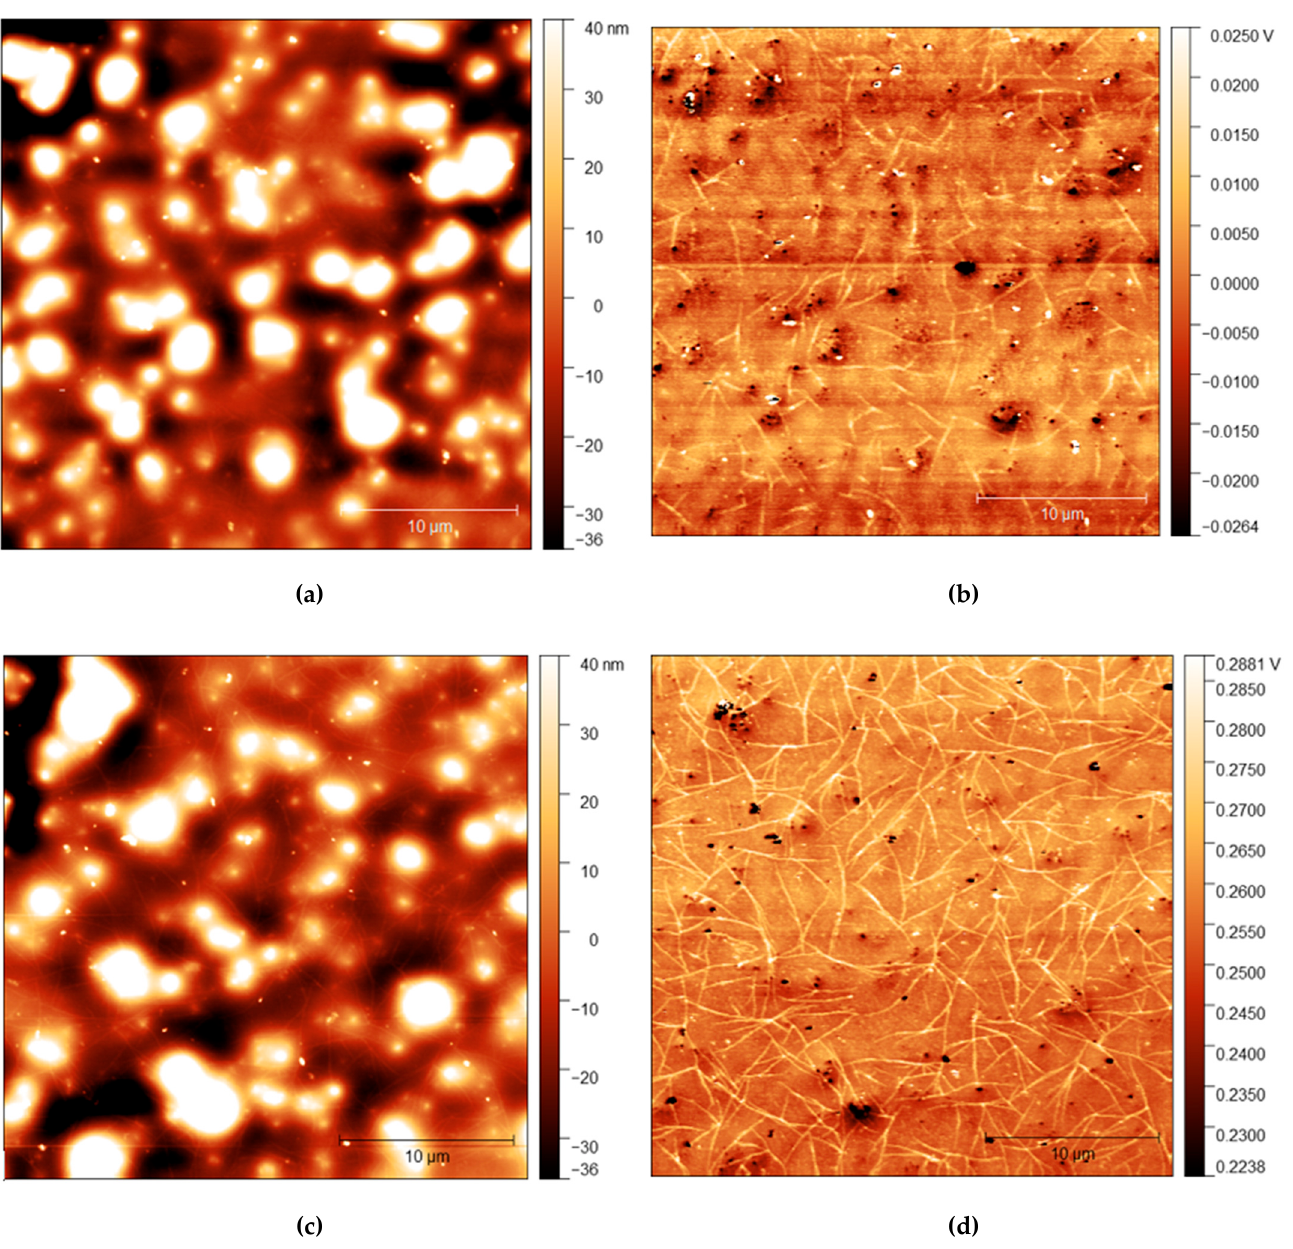
Figure 5. (a) AFM height map of cis -PI films with 2.5% loading of C 12 E 5 and (b) Adhesion maps for the same position on 297 Figure 5. ( a ) AFM height map of cis -PI films with 2.5% loading of C 12 E 5 and ( b ) Adhesion maps for the same position on the same film; (c) height map of the same film shown in the top AFM images after 10s rinse and (d) the adhesion map. 298 the same film; ( c ) height map of the same film shown in the top AFM images after 10 s rinse and ( d ) the adhesion